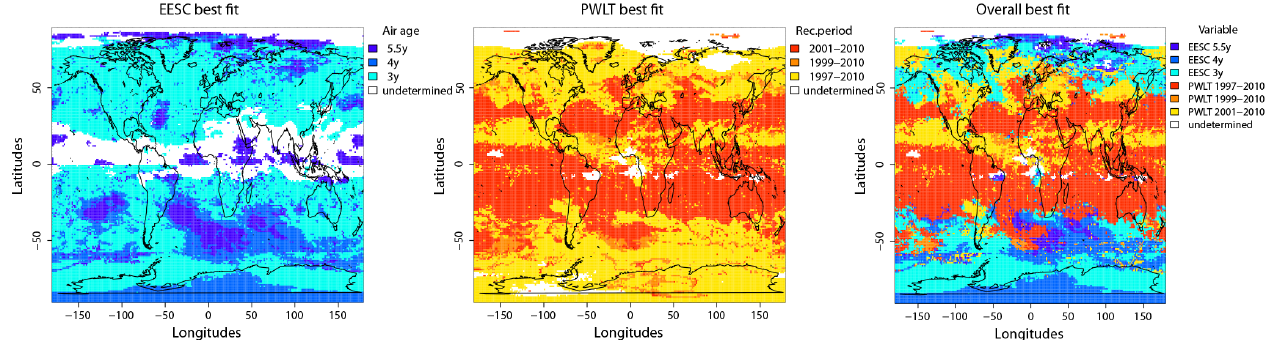
Figure 13. Comparison of R 2 values of PHYS regression runs depending on the parameterization for long-term ozone variation by the EESC with air ages of 3, 4 or 5.5 years or a piecewise linear function with the second linear component spanning 1997–2010, 1999–2010 or 2001–2010. The left plot illustrates which age-of-air parameter results in the highest R 2 value among the EESC parameterizations. The middle plot similarly illustrates which recovery period achieves the highest performance in terms of R 2 . The right plot shows the result of similar comparisons among all parameterizations for long-term ozone variation. White regions indicate nonsignificant regression estimates for each of the considered explanatory variables based on a 99% significance